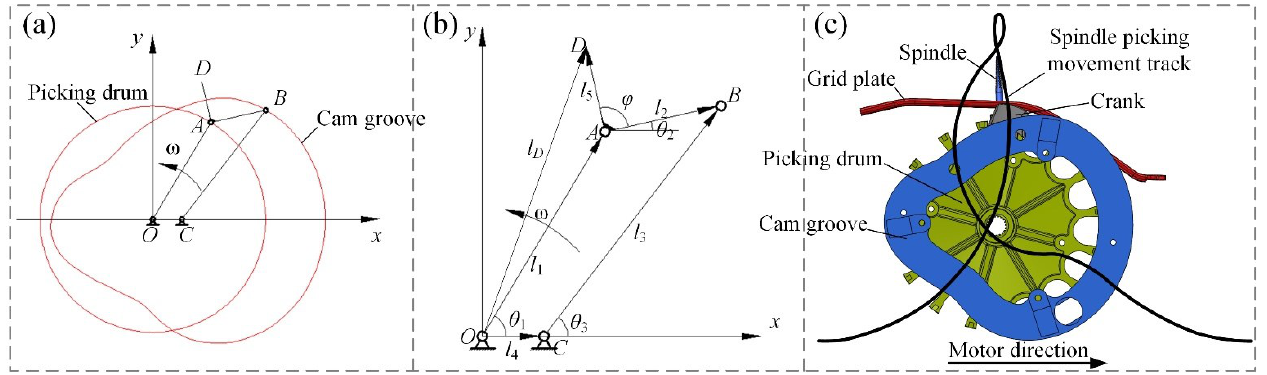
Figure 1. Kinematics analysis of the spindle picking process: ( a ) variable rod length double crank guide rod mechanism, ( b ) closed vector polygon, and ( c ) spindle-picking movement track.